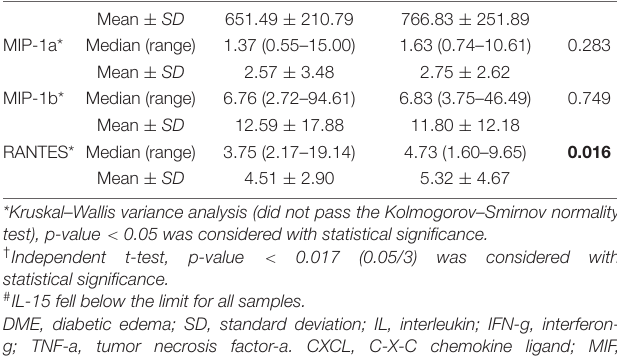
TABLE 4 | Inflammatory cytokines and chemokines between PDR patients with or with no early ME after surgery. No DME